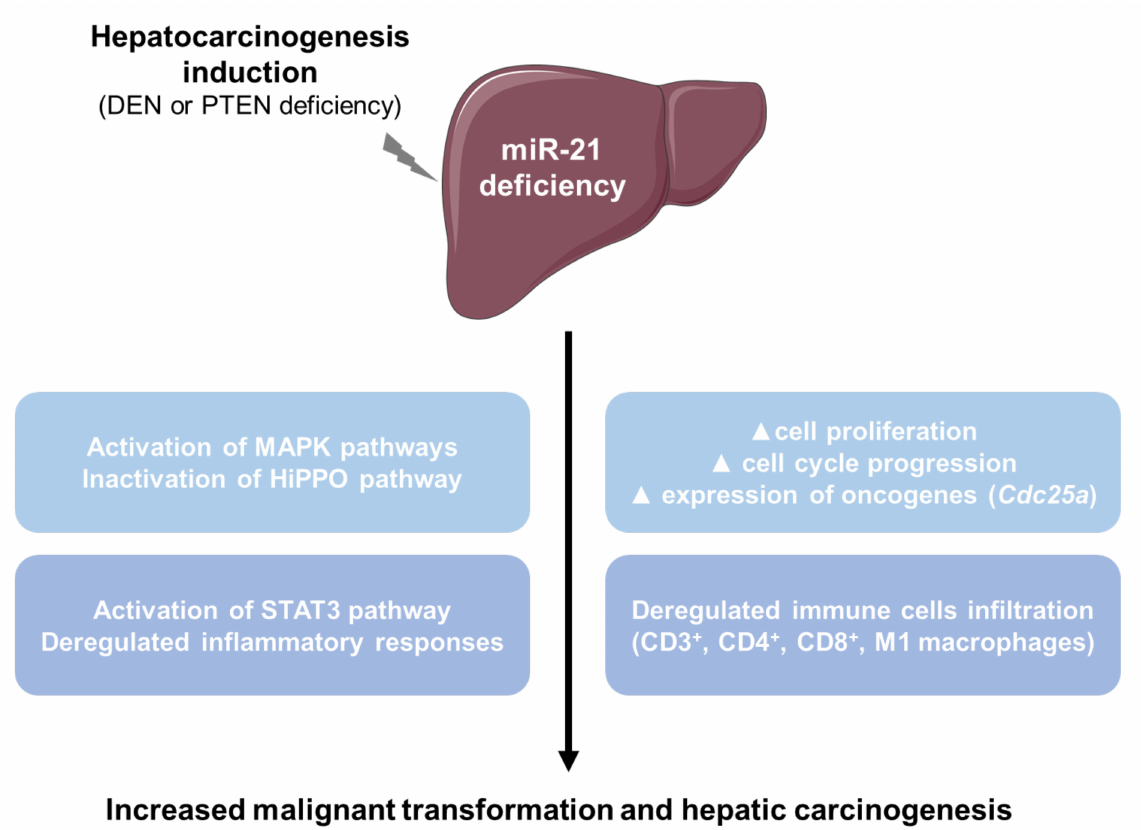
Figure 8. miR-21 deficiency promotes hepatocarcinogenesis in two distinct HCC animal models through pleiotropic mecha- nisms. These mechanisms involve subtle alterations of pro-oncogenic (MAPK, HiPPO pathways) and pro-inflammatory signaling pathways (STAT3 pathways), increased cell proliferation and cell cycle progression, increased expression of oncogenes (e.g., Cdc25a ), and deregulated immune cells’